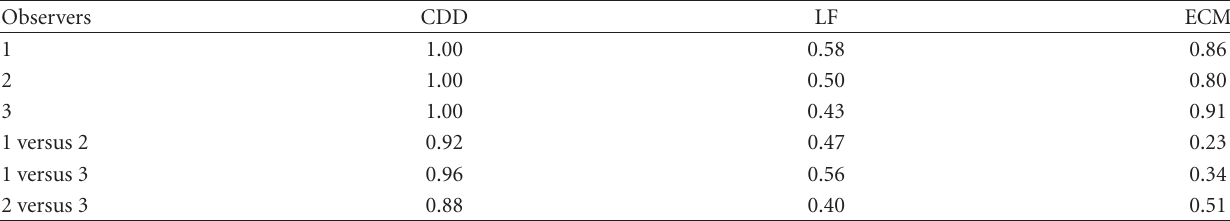
Table 2: Kappa values of inter- and intraobserver repeatability for CDD, LF, and ECM. Observers CDD LF